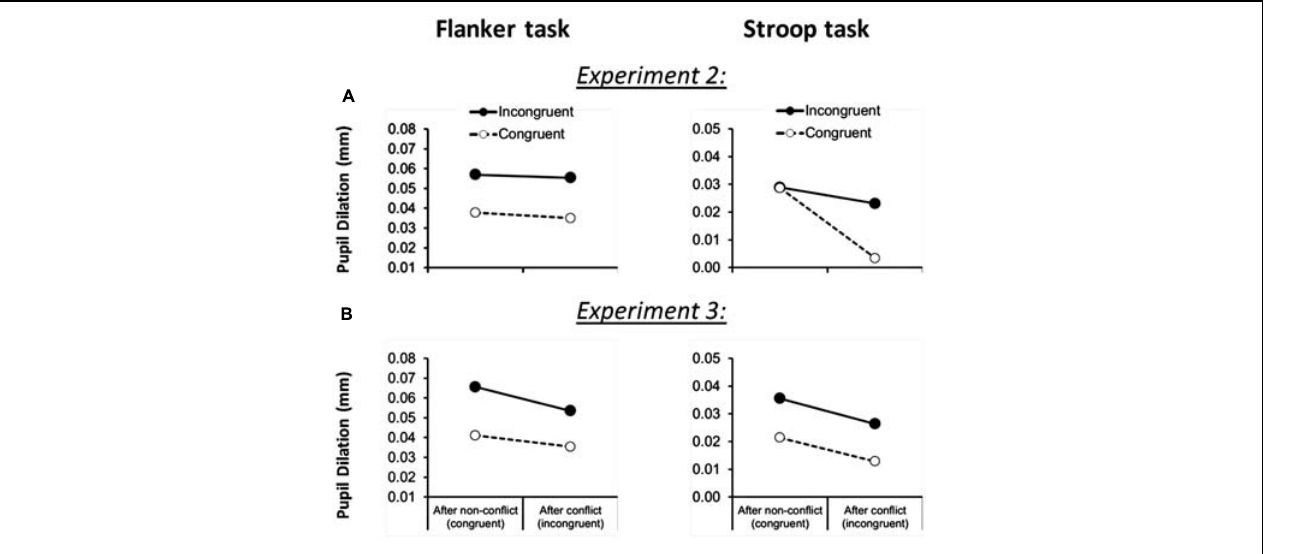
FIGURE 3 | Flanker task (left column) and Stroop task (right column) pupil dilation across Experiment 2 (A) and 3 (B), as a function of current-trial congruency and previous-trial congruency. Please note that data from the Stroop task in Experiment 2 suggests